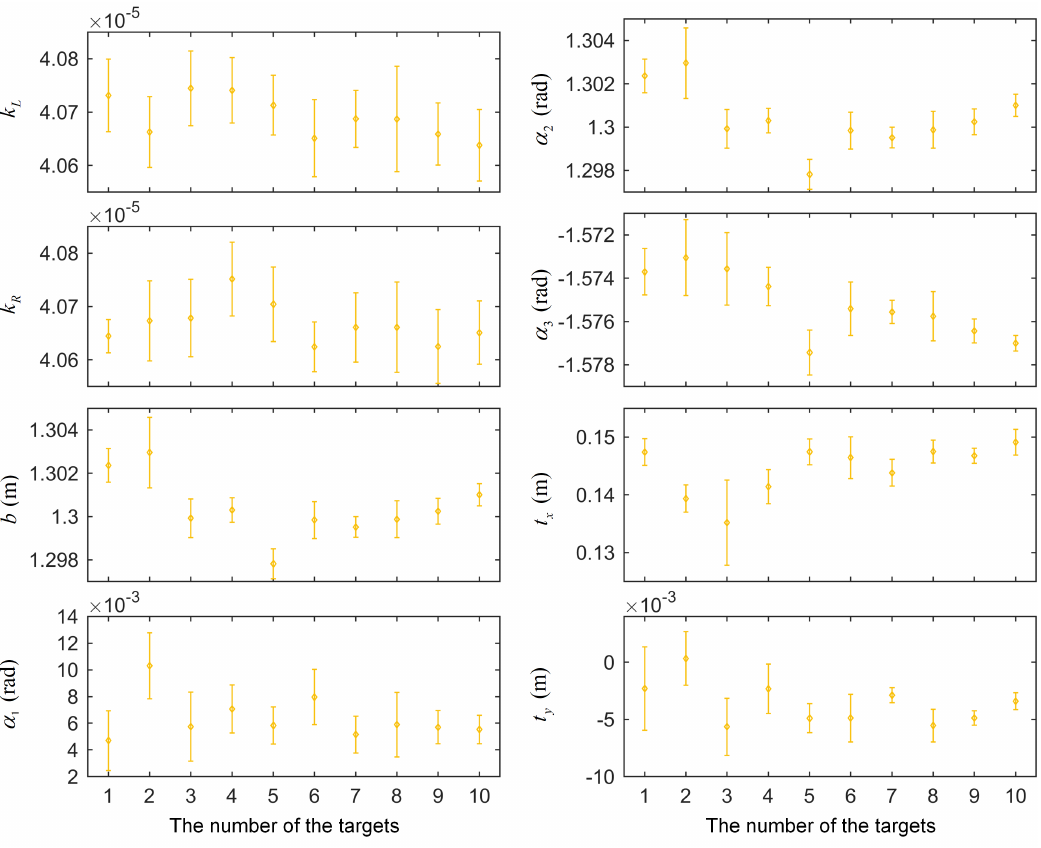
Figure 13. Calibration results with different numbers of the